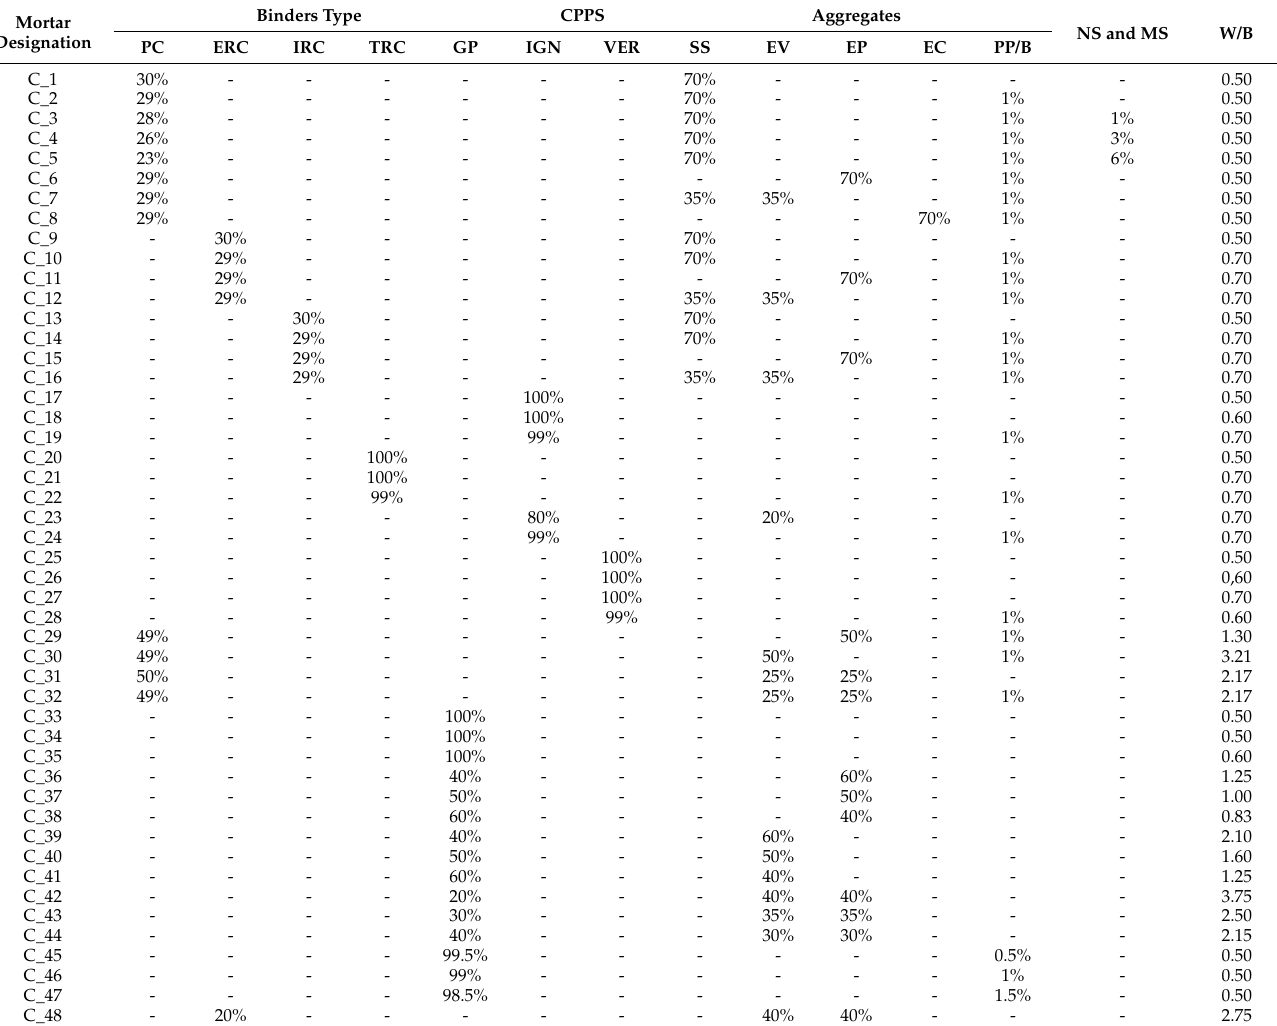
Table 1. Mortar compositions developed at LEMEC (a) (amount of materials in volume